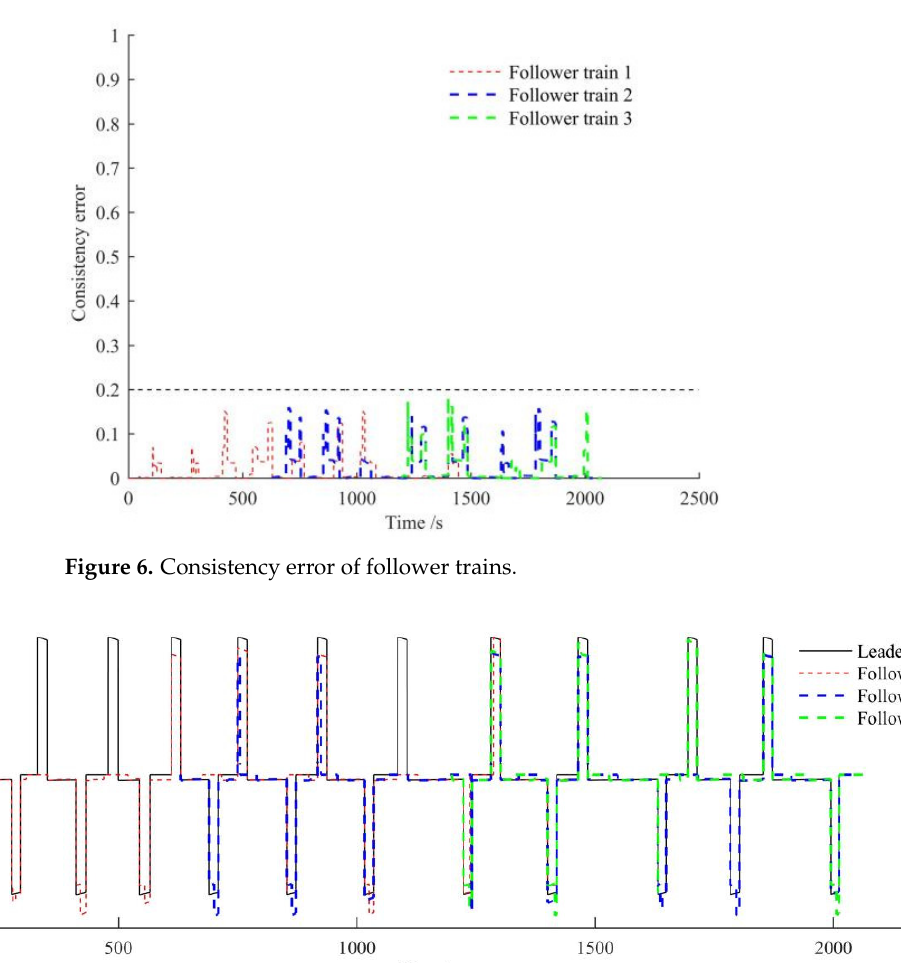
Figure 5. Trigger time of follower trains.